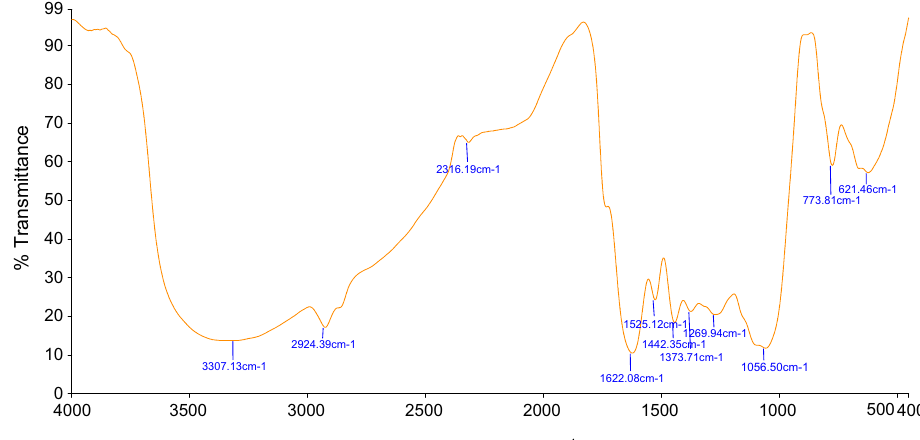
Fig. 2 FTIR spectrum chart of Brachystegia eurycoma precur- sor